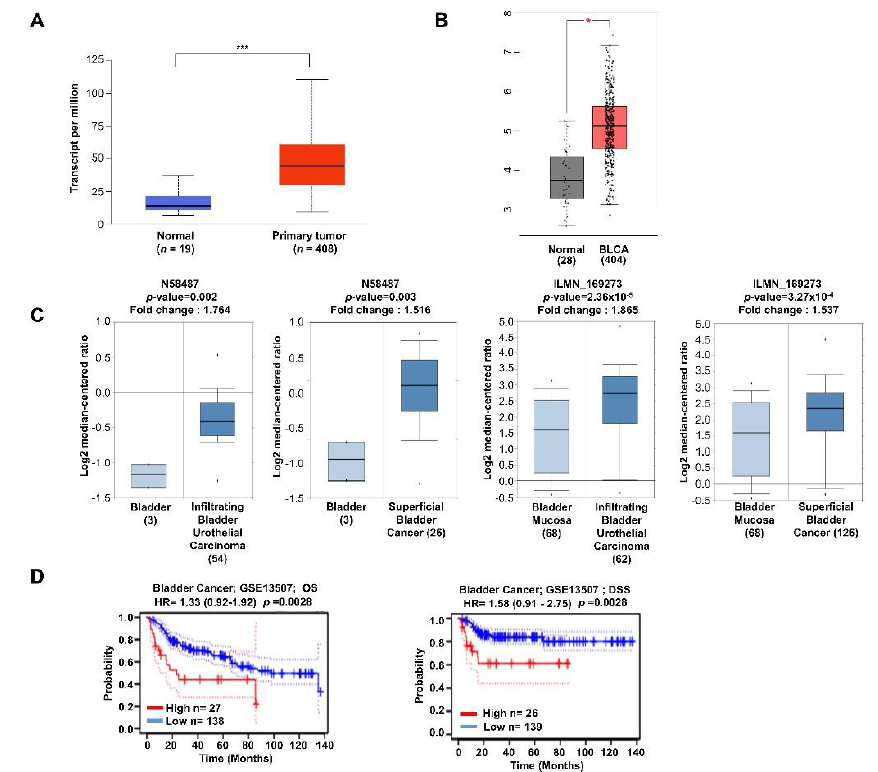
Figure 1. Analysis of TTYH3 mRNA expression pattern and prognosis in bladder cancer. ( A ) Comparison of the expression of TTYH3 in normal and bladder urothelial carcinoma (BLCA) tissues using the UALCAN database. Red boxes represent tumor tissues and blue boxes represent normal tissues. Red and blue dashed lines represent the average expression value of all tumor and normal tissues, respectively. ( B ) Comparison of the expression of TTYH3 in normal and BLCA tissues using the GEPIA2 database. Red boxes represent tumor tissues and gray boxes represent normal tissues. ( C ) Analysis of TTYH3 expression levels in bladder cancer versus normal tissues on the Oncomine dataset. The threshold was designed using the following specific parameters: p – value = 1 × 10 5 and fold change = 1.5. ( D ) The graph compares the survival rate of high (red) and low (blue) expression of TTYH3 in bladder cancer patients using the PrognoScan database. (* p ≤ 0.05, *** p ≤ 0.001 ). 2.2. TTYH3 Knockdown Suppresses Tumor Growth and Proliferation in Bladder Cancer Cells To confirm that TTYH3 expression affects bladder cancer function, we performed some in vitro assays in bladder cancer cell lines. The expression of TTYH3 was compared in various cancer cell lines. The expression of TTYH3 was higher in bladder cancer cell lines than in other cancer cell lines and higher in cell lines derived from high-grade tran- sitional cell carcinomas, such as T24 and J82 cell lines (Figure 2A). We were interested in investigating the mechanisms involved in TTYH3 expression in bladder cell lines. To un- derstand the role of TTYH3 in bladder cancer cells, we used a lentiviral TTYH3 knock- down vector to suppress TTYH3 expression in J82 and T24 cells. The knockdown of TTYH3 was confirmed by reverse transcription-polymerase chain reaction (RT-PCR) (Ta- ble 1). TTYH3 expression was reduced by more than half in J82 and T24 cells. TTYH3